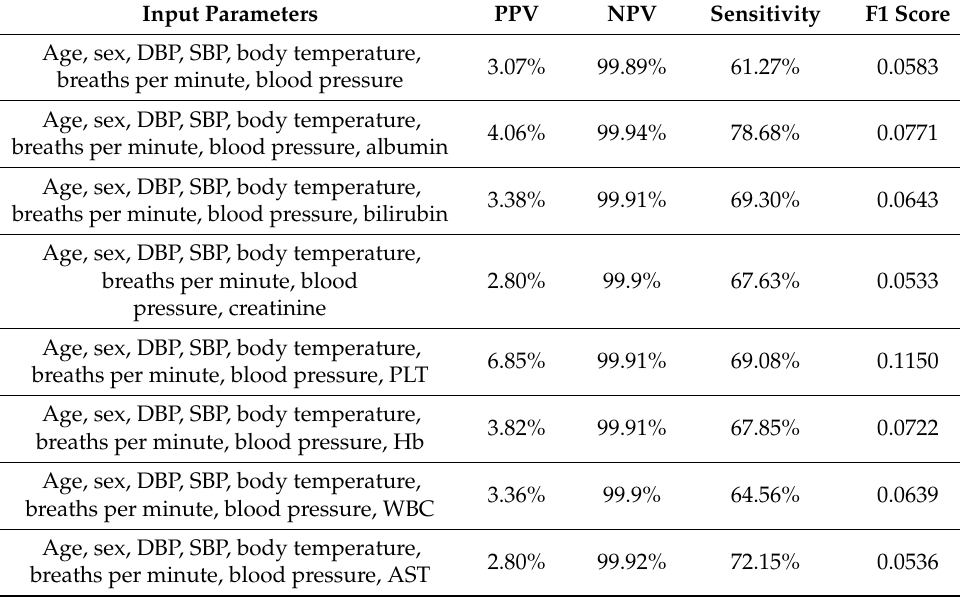
Table 7. Performance evaluation of each